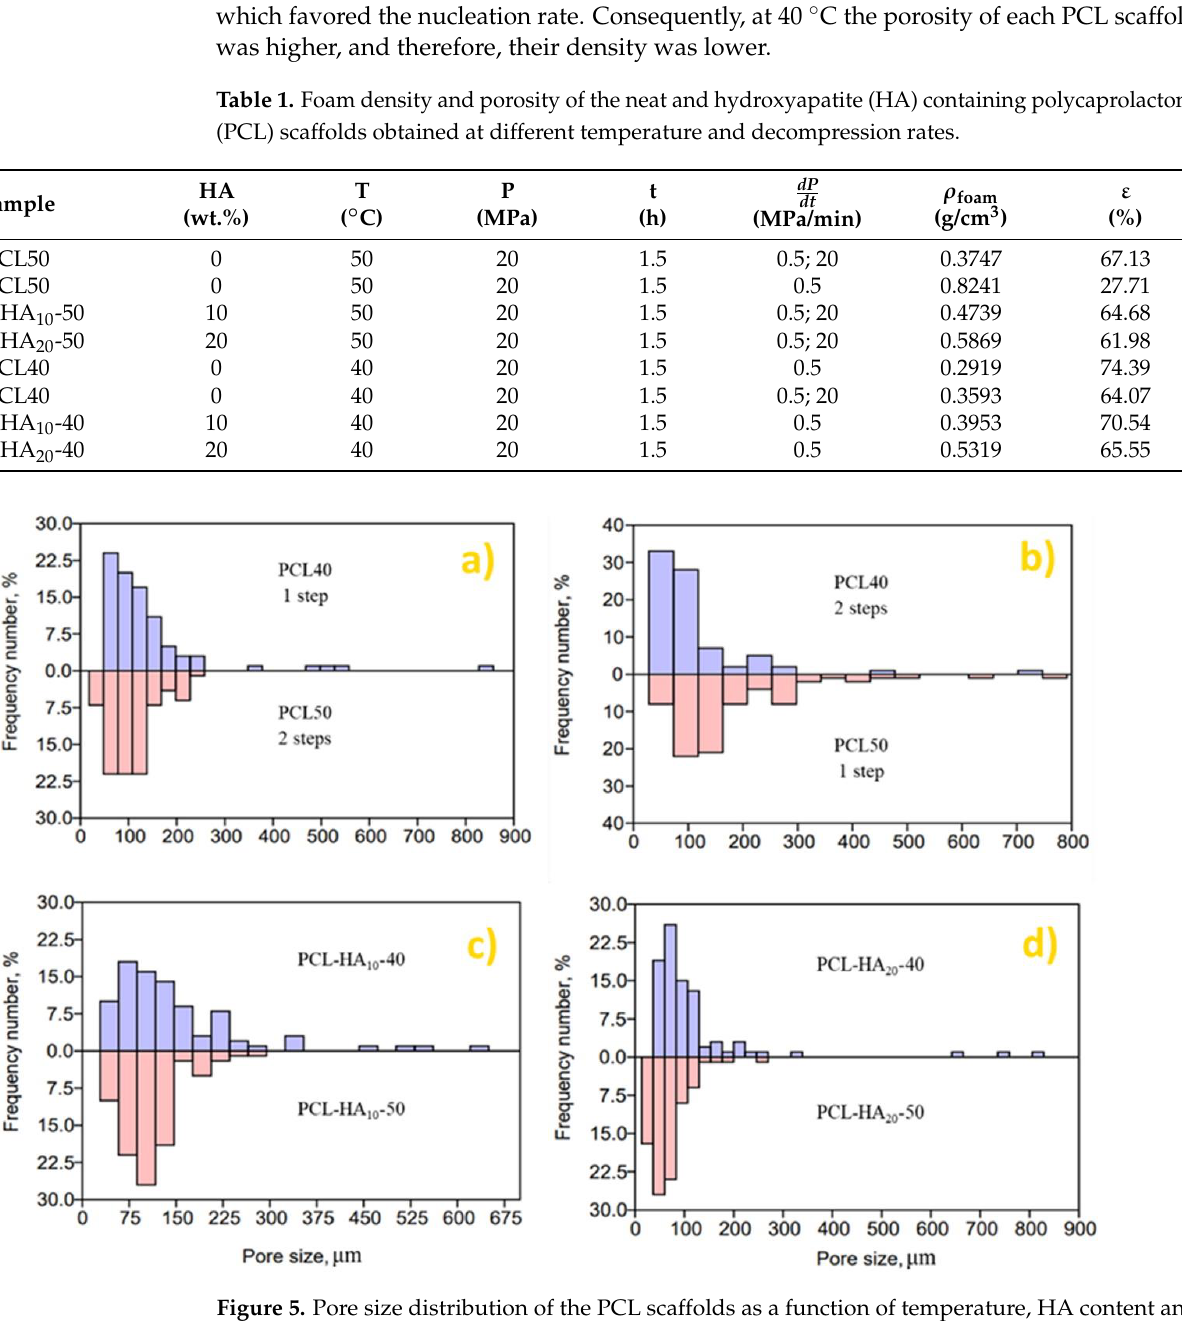
Figure 5. Pore size distribution of the PCL scaffolds as a function of temperature, HA content and decompression type; neat PCL ( a , b ), PCL with 10% HA ( c ), PCL with 20% HA ( d ).